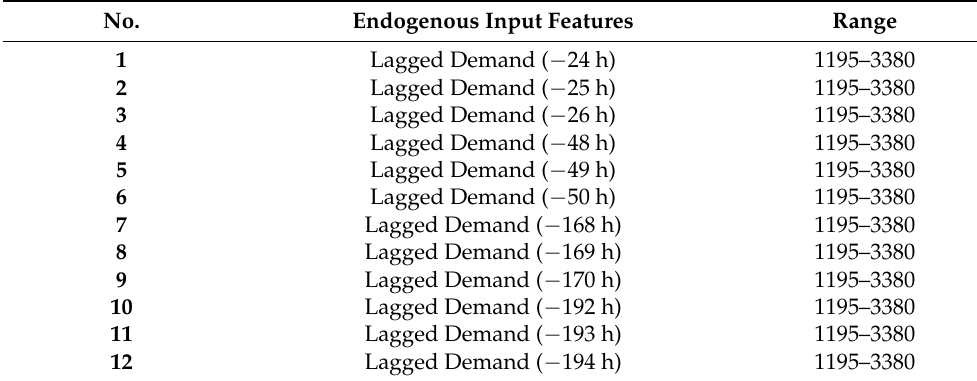
Table 6. Endogenous input features related to the demand at previous hours of the